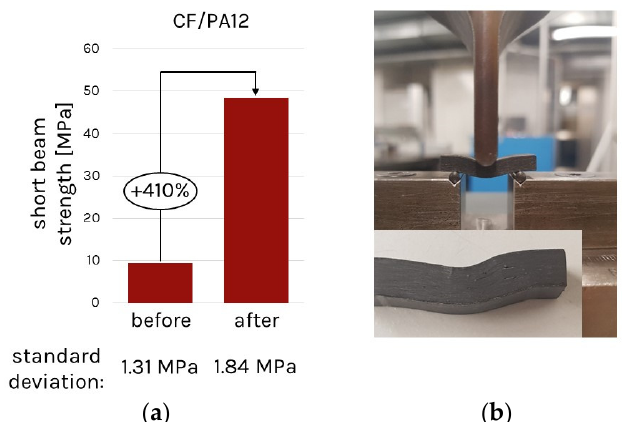
Figure 2. Preliminary study on the change in short beam strength for the PA12/CF material before and after fusion: ( a ) comparison of the strength before and after the consolidation; ( b ) experimental setup and resulting part’s deformations.